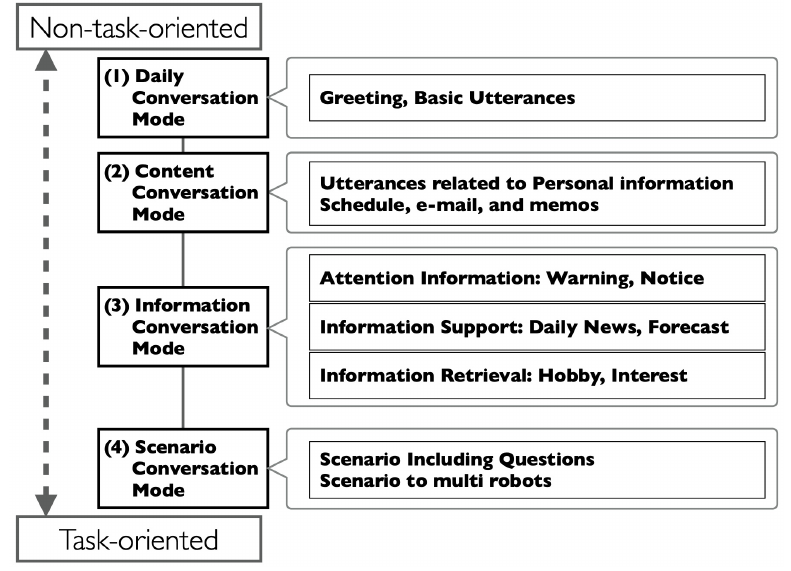
Figure 12. Conversation modes for robot